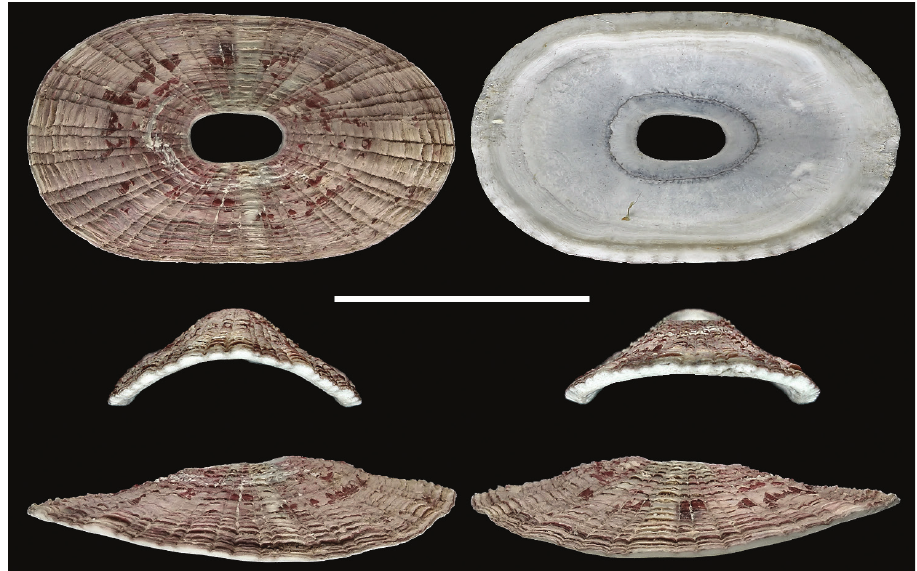
Figure 16. Amblychilepas platyactis McLean & Kilburn, 1986. Holotype T2744/NMSA-MOL 0B6397. Scale bar: 10